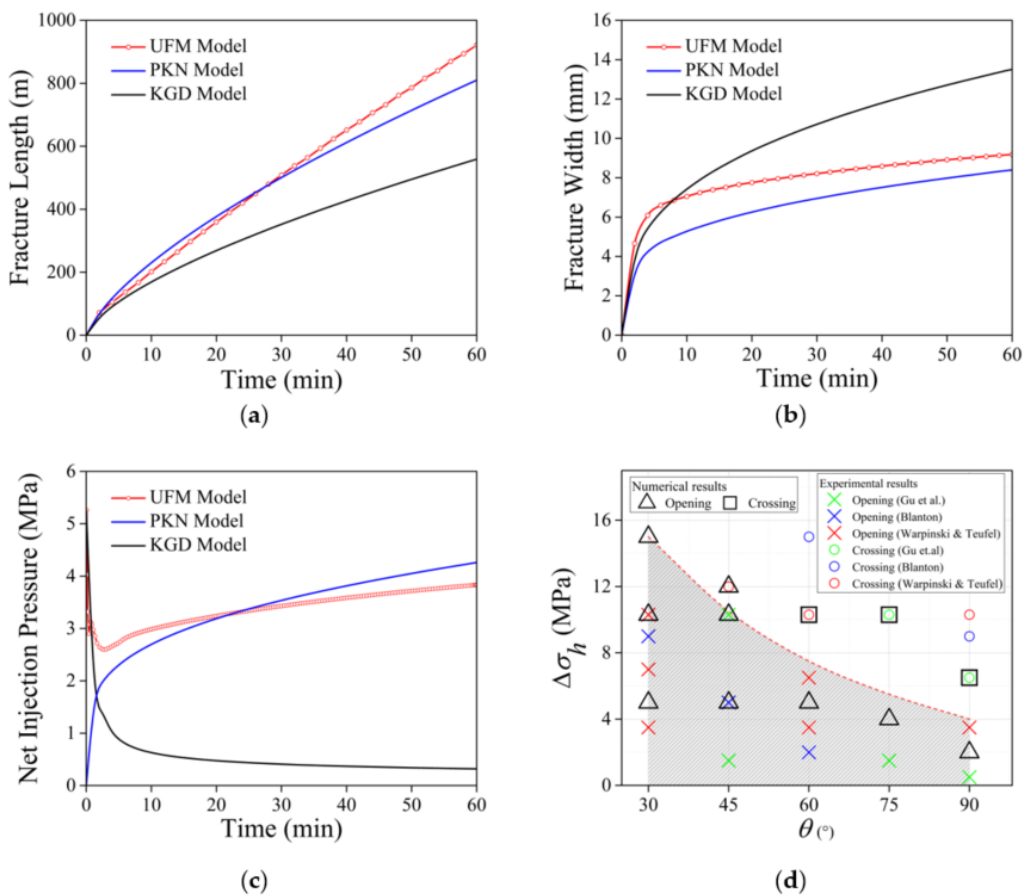
Figure 9. Comparison between the UFM model and the PKN/KGD models for a bi-wing HF, and experiments for the HF–NF interaction: ( a ) fracture length vs. time curves; ( b ) fracture width vs. time curves; ( c ) net injection pressure vs. time curves; ( d ) the HF crossing or opening the NFs at different θ and ∆ σ h